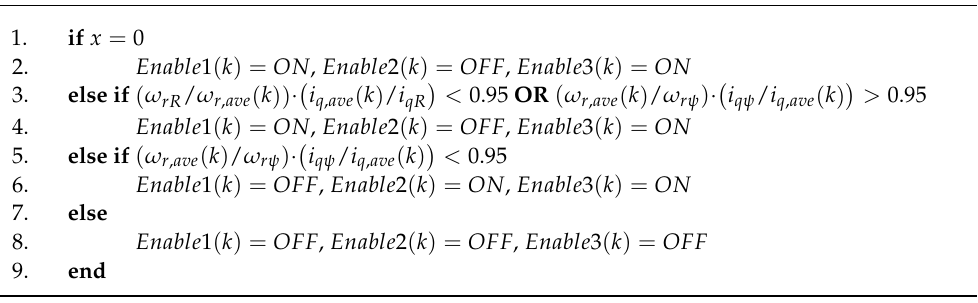
Algorithm A1. Operating condition check and AdNNs enable.